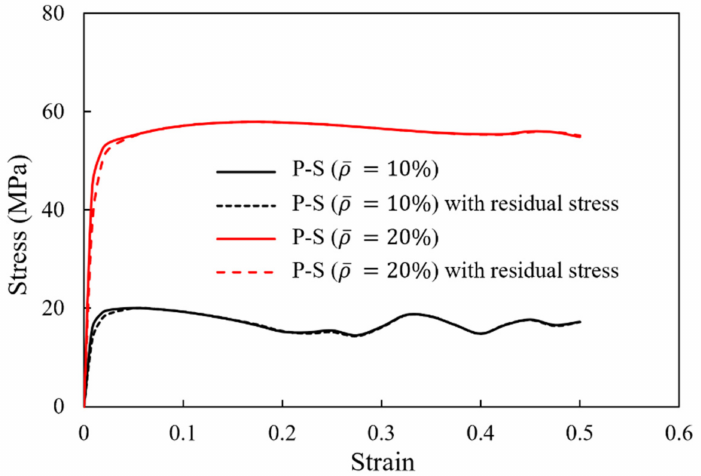
Figure 19. Stress–strain compression response for P-S lattice of ρ = 10% and 20%, with and without the effect of residuals